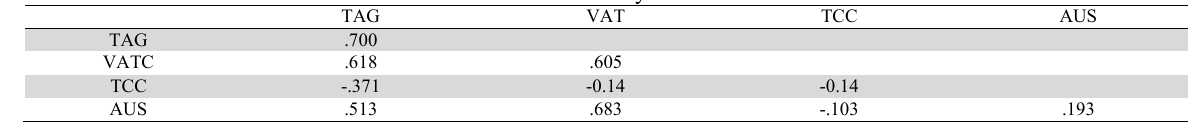
Heterotrait-Monotrait Ratio to Examine the Discriminant Validity